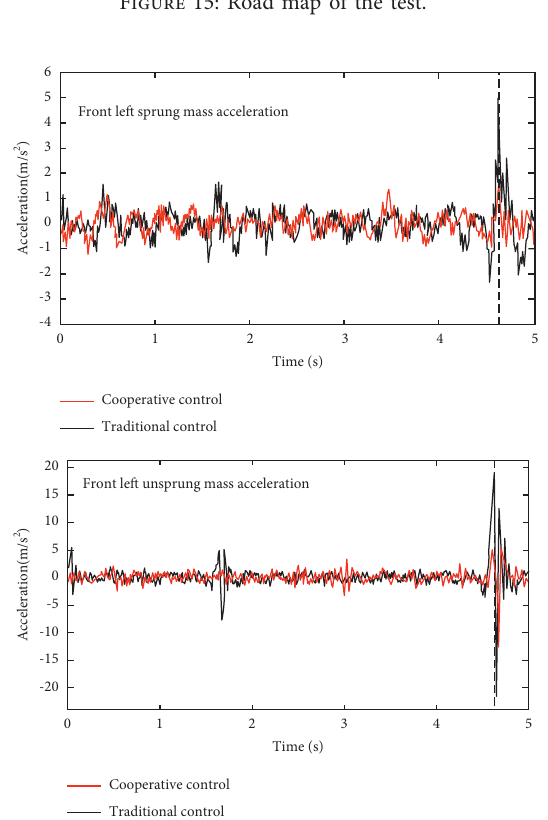
Figure 16: Segment acceleration of front left sprung and unsprung